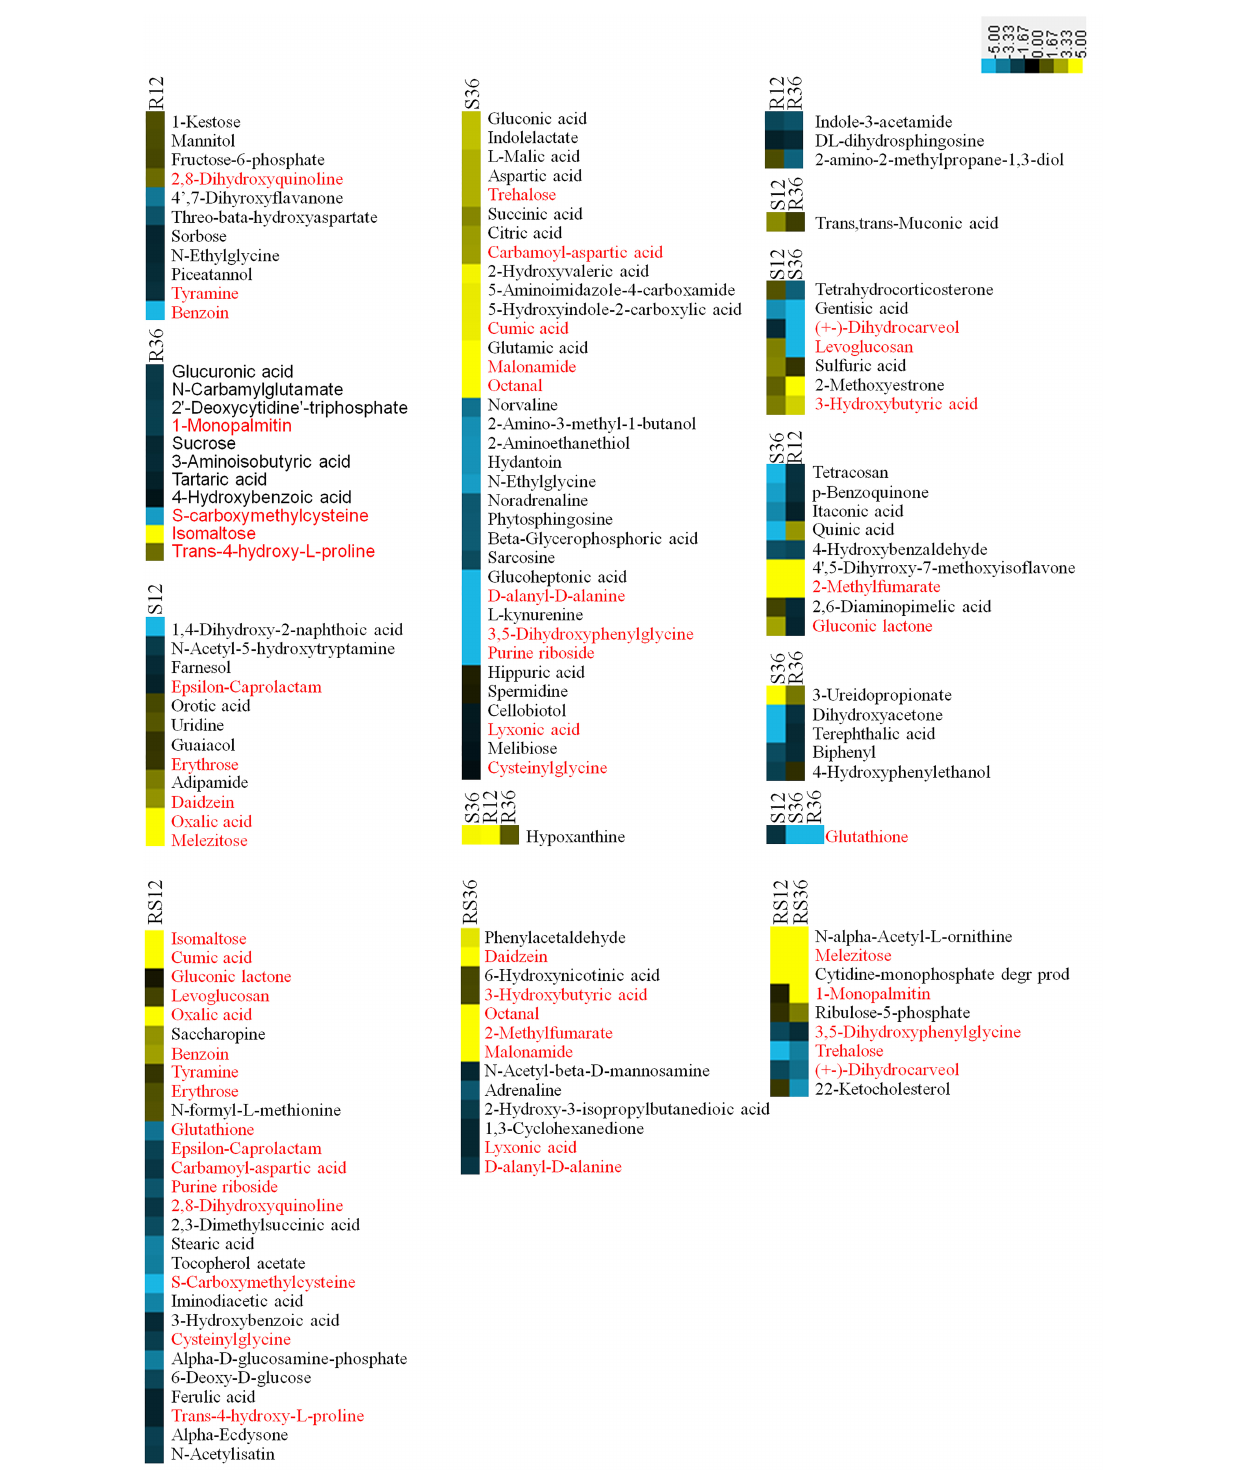
Frontiers in Plant Science |